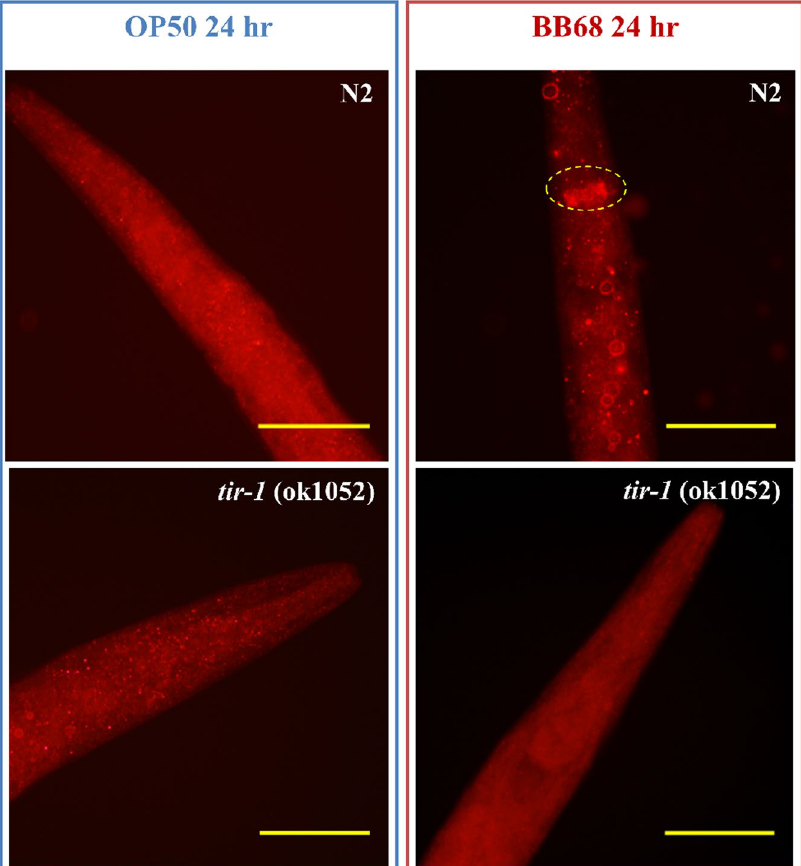
Figure 2. Feeding N2 worms BB68 for 24 h activated JNK-1 via phosphorylation. The phospho-JNK/SAPK (Thr183/Tyr185) antibody and Cy3-labeled goat anti-mouse IgG (H + L) were used as primary and secondary antibodies, respectively. The dashed circle indicates phosphorylated JNK-1 in the nerve ring, but no activated JNK-1 was detected in the presence of mutant tir-1 .